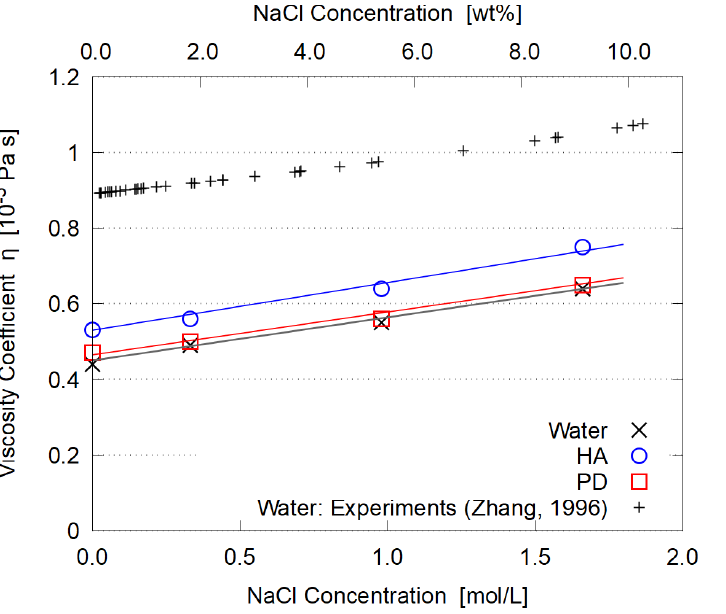
Figure 13. Salt concentration dependence of dynamic viscosity η . Experimental data for NaCl solutions (without polymers) are taken from Ref. [51]. Lines are drawn as a guide for the